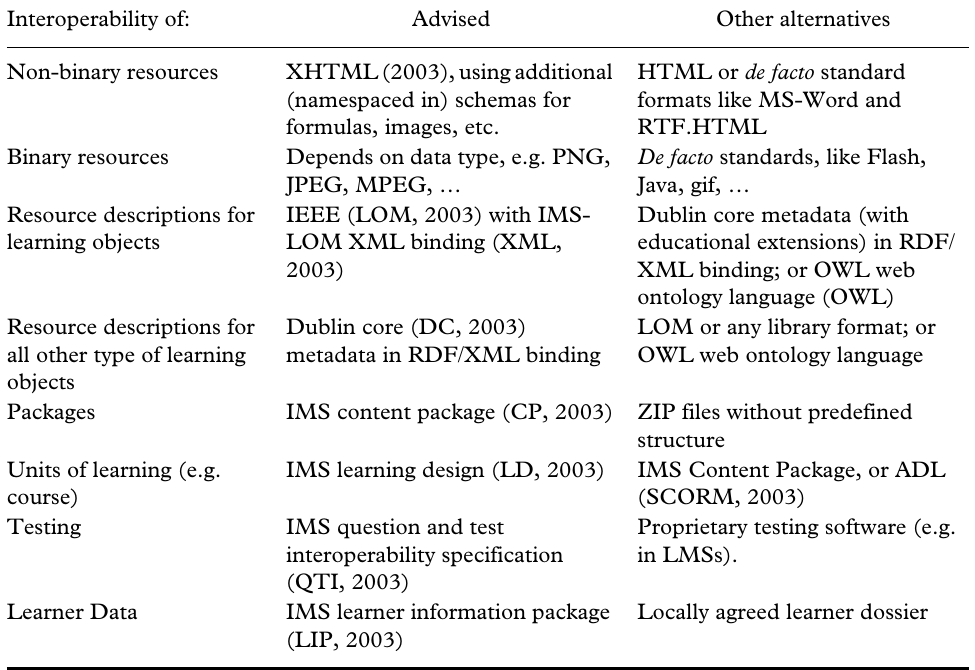
Table 1. Suggested use of interoperability specifications in exchange communities Interoperability